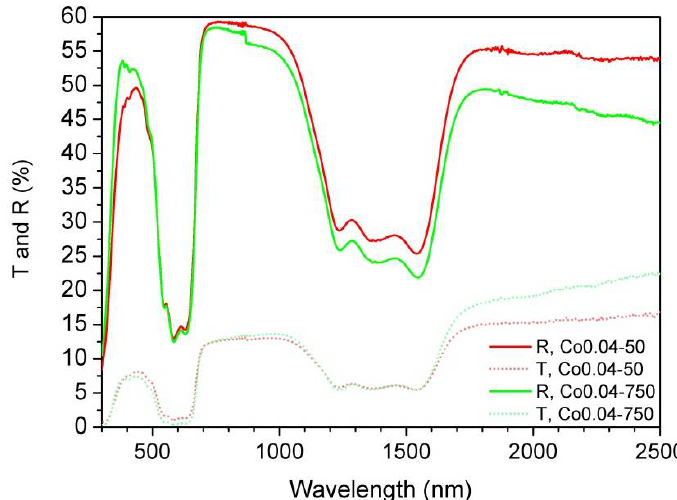
Figure 8. Measured directional-hemispherical reflectance (continuous lines) and transmittance (dotted lines) of as-grown samples Co0.04-50 (red and light-red) and Co0.04-750 (green and light-green). The incident light beam is perpendicular to the samples rod-axes.